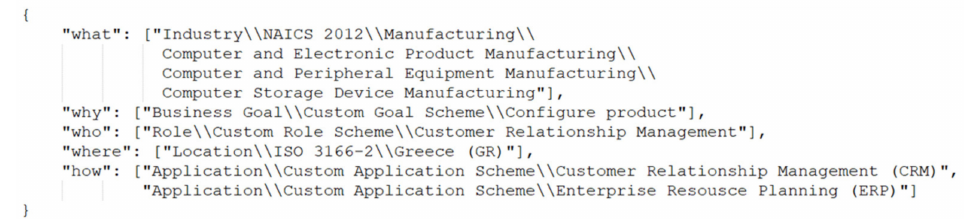
Figure 4. An example of one BPC of a business process serialized in